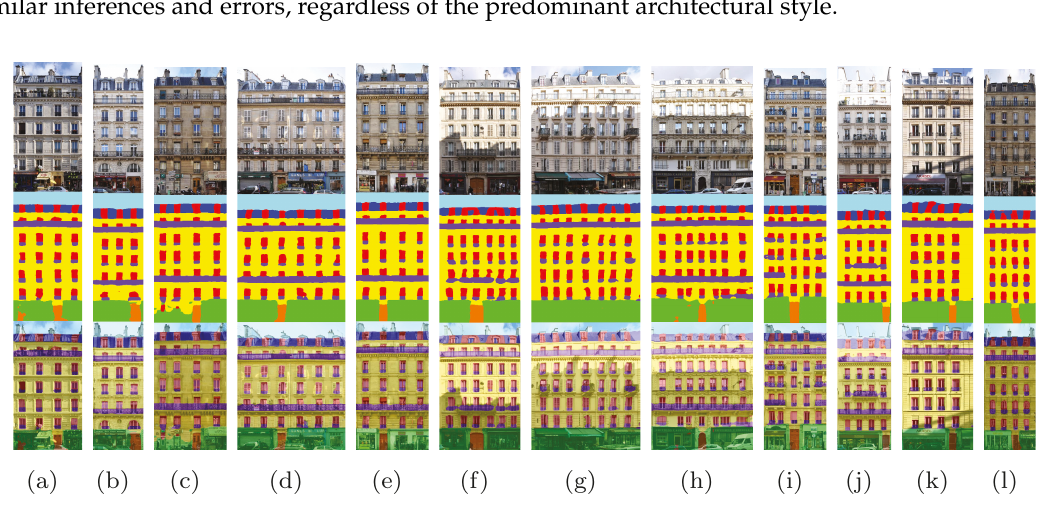
Figure 9. Results over the ECP dataset. ( a – l ) Example of ECP images, segmented by the neural model presented in Section 4.1.2. The three different rows correspond to the same description as in Figure